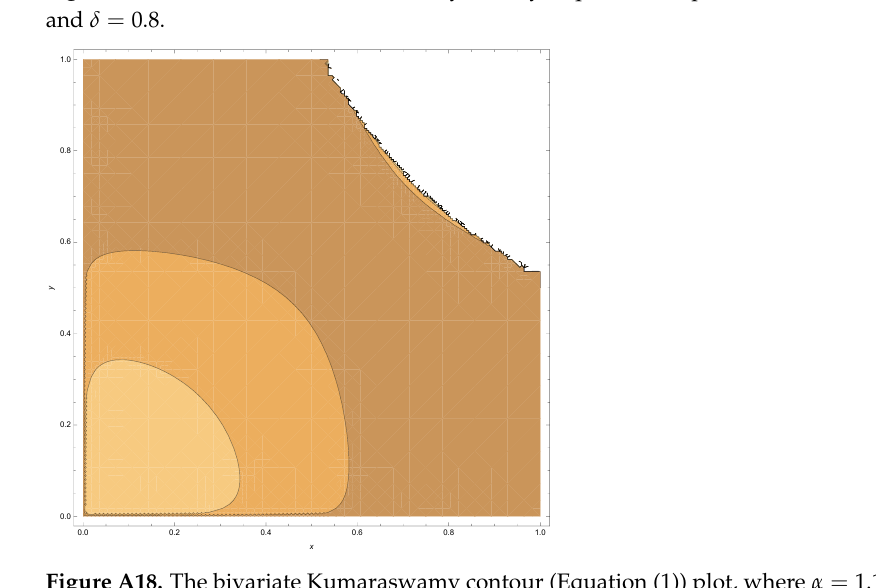
Figure A18. The bivariate Kumaraswamy contour (Equation (1)) plot, where α = 1.1, β = 1.1, θ = 2 and δ =